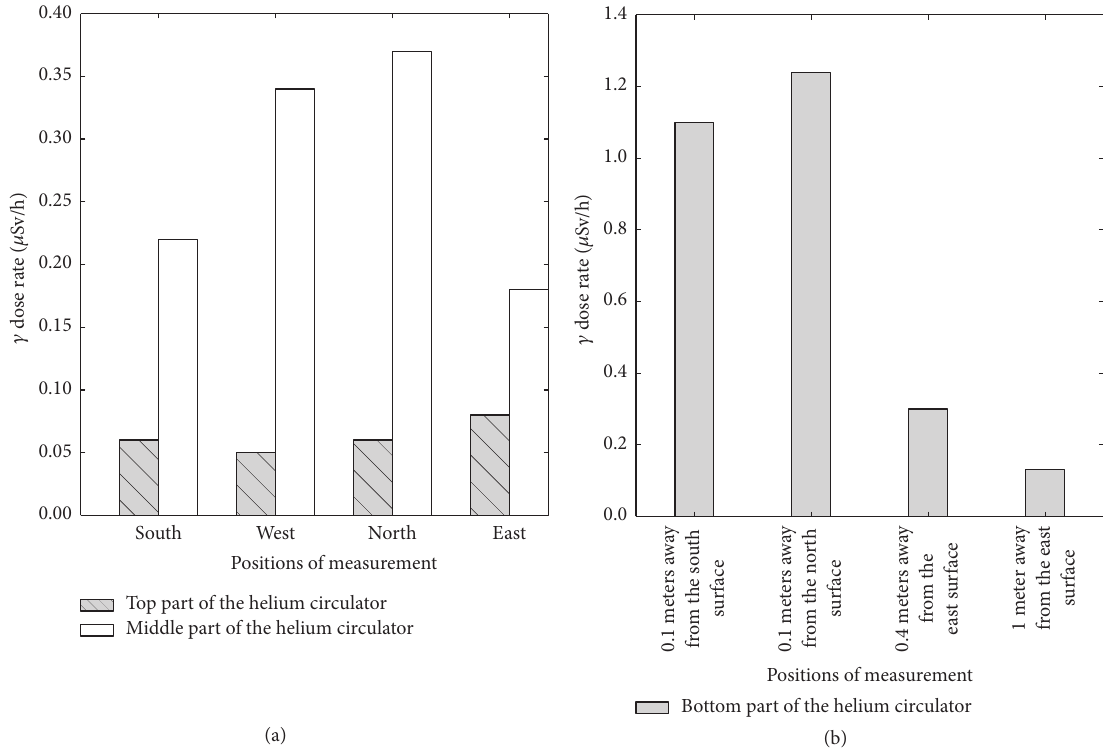
Figure 7: 𝛾 dose rates near the top, the middle, and the bottom parts of the removed helium circulator during the maintenance. (a) The dose rates measured at 0.1 meters away from the top and middle parts of the helium circulator; (b) the dose rates measured at different distances away from the bottom part of the helium circulator.